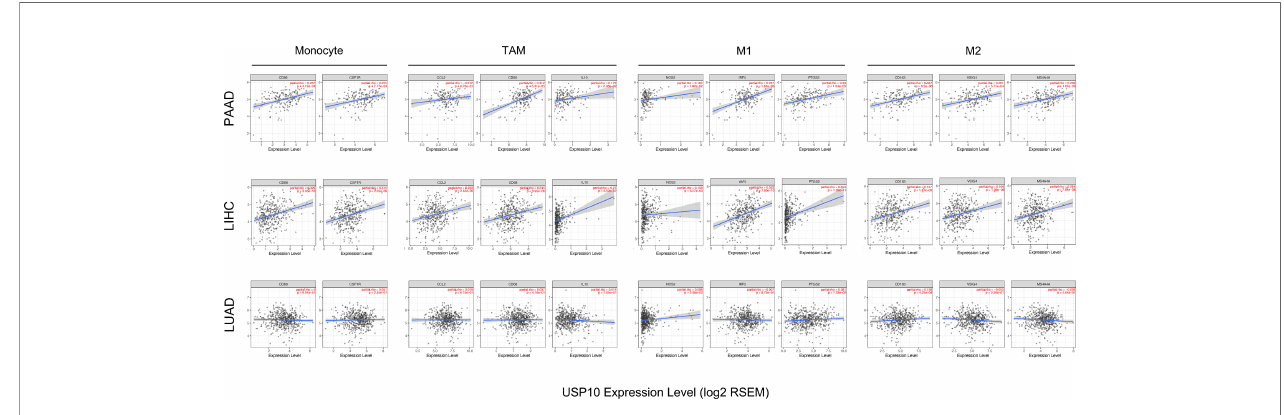
FIGURE 9 | The correlation between the expression of USP10 and marker genes for M2 macrophages, M1 macrophages, TAMs, and monocytes in LUAD, LIHC, and PAAD, as shown by scatter plots. The monocyte markers were CSF1R and CD86 ; the markers for TAMs were CCL2 , CD68 , and IL10 ; the markers for M1 macrophages were PTGS2 , IRF5 , and NOS2 ; and the markers for M2 macrophages were MS4A4A , VSIG4 , and CD163 . PAAD, pancreatic adenocarcinoma; LIHC, liver hepatocellular carcinoma; LUAD, lung adenocarcinoma. TAMs, tumor-associated macrophages. Signi fi cance is indicated by a P -value < 0.05.